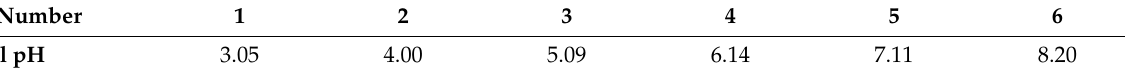
Table 4. pH of successive portions of eluate from column lysimeter